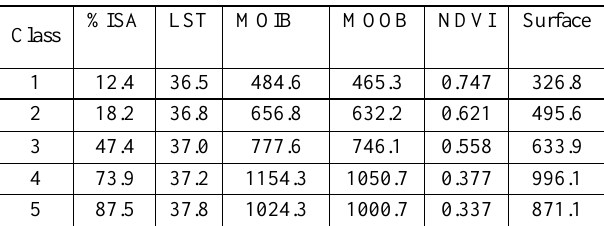
Table 4. The physical characteristics of LCZ of UHI in